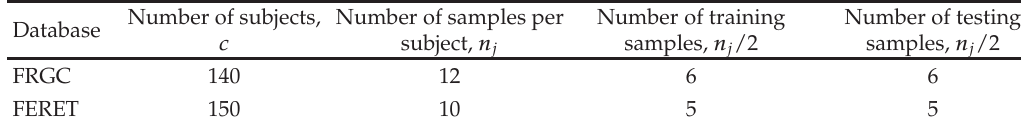
Table 1: Details of FRGC and FERET databases.